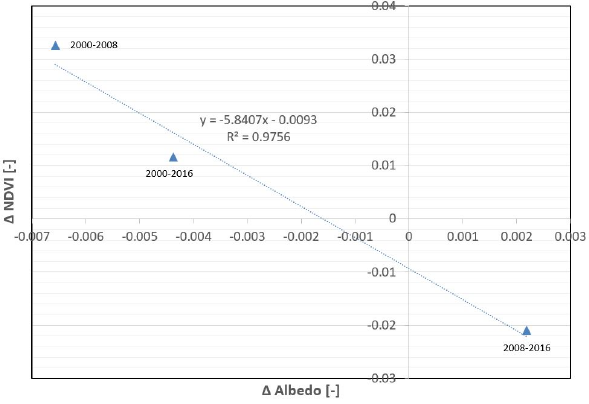
Figure 8. Correlation between temporal changes in NDVI and surface albedo.